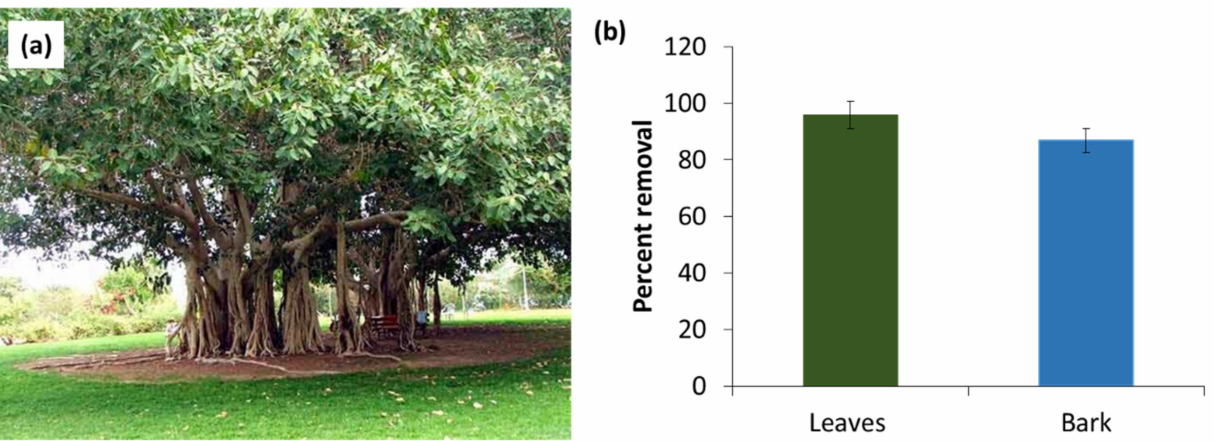
Figure 1. ( a ) F. benghalensis tree. ( b ) Comparison of adsorption performance of F. benghalensis tree leaves and bark to remove BG